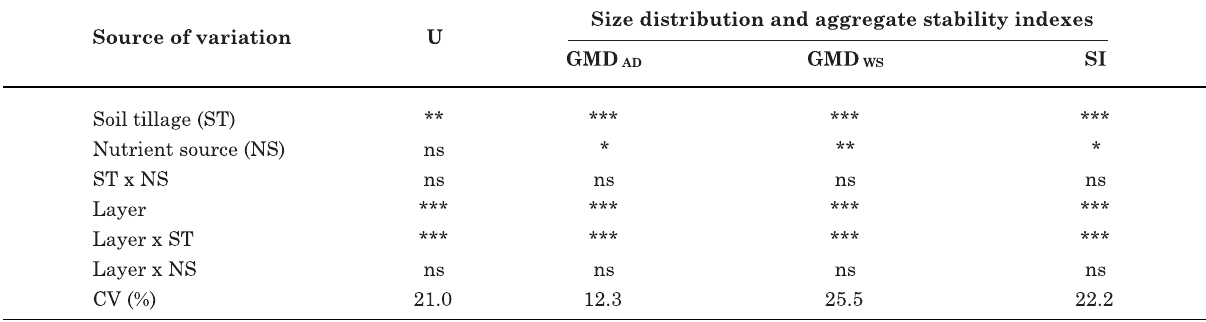
U: gravimetric moisture; GMD stable aggregates; and SI: stability index of aggregates. ***, **, *, and ns: statistical significance at 0.1, 1 and 5 % and non-